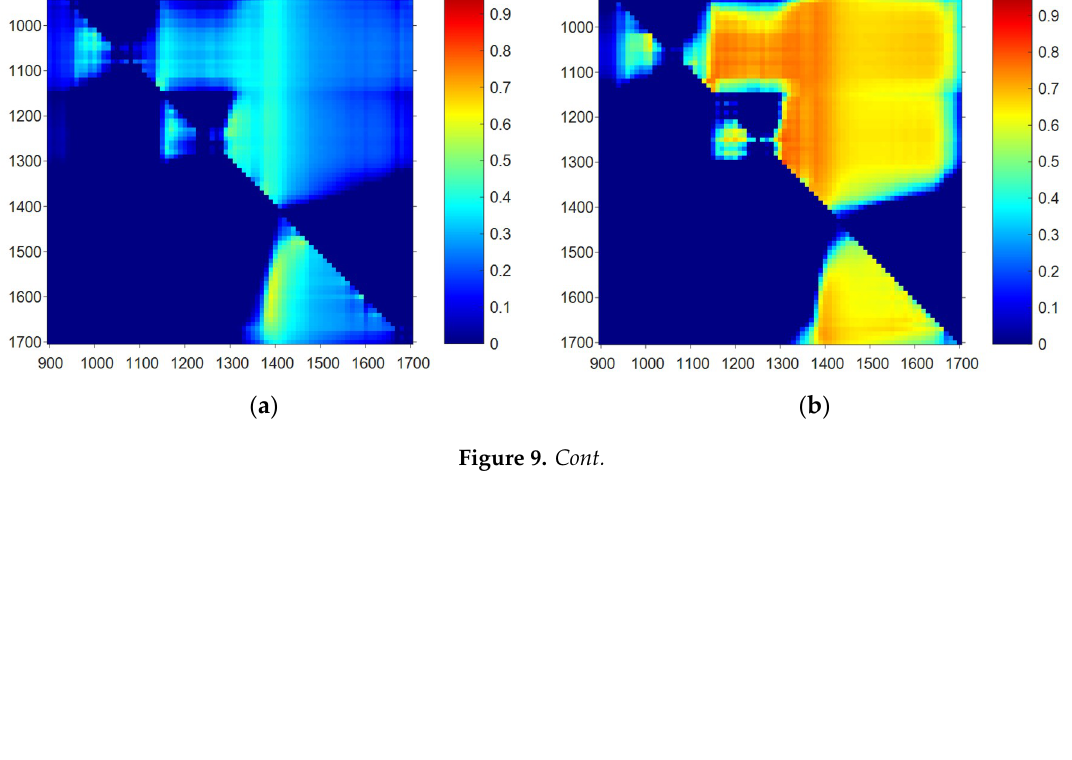
( f ) Figure 9. Normalized difference vegetation index (NDVI) of tomato wavelength and leaf water status. ( a ) RAW and WC; ( b ) RAW and MC; ( c ) LOG and WC; ( d ) LOG and MC; ( e ) DIFF and WC; ( f ) DIFF and MC.